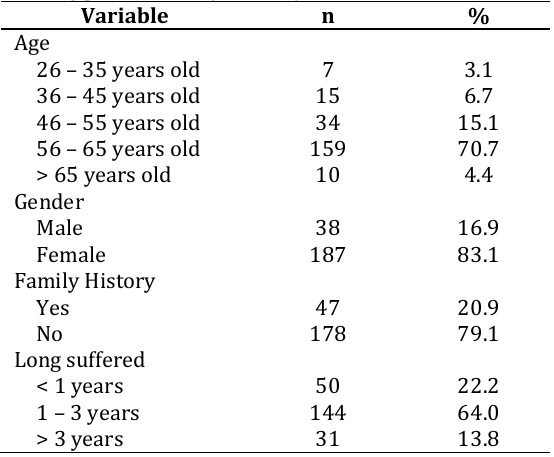
Table 1. Demographic Characteristics of Patients